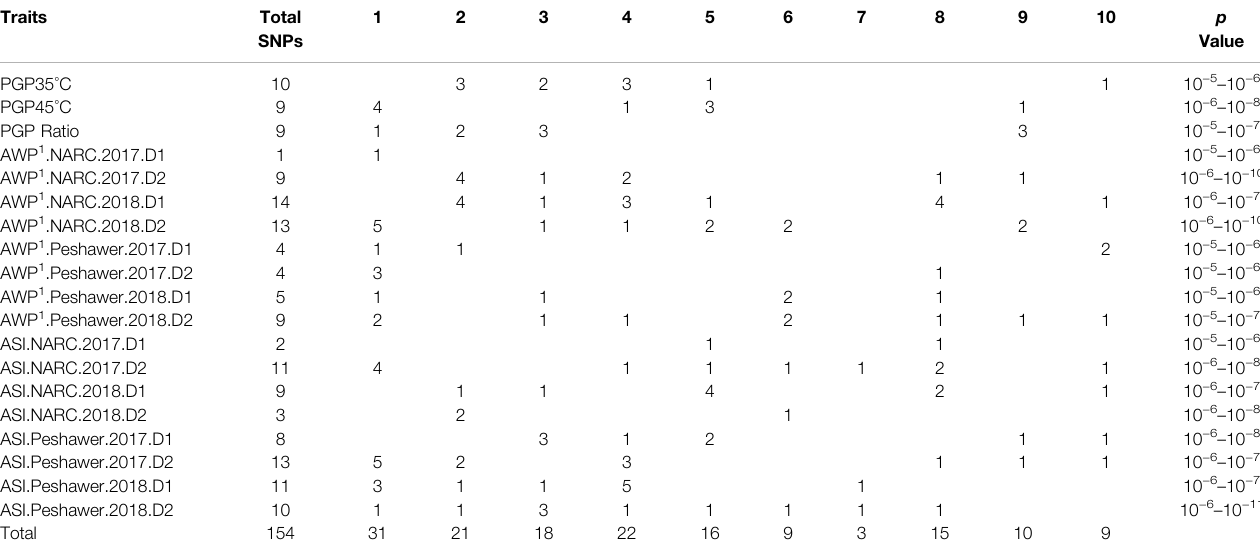
TABLE3| Genomewideassociationstudies(GWAS)resultsindicatingSNPsassociationswiththetargettraitsundervariousconditionsusing122(PGP)or262(AWP − 1 and ASI) diverse maize inbred